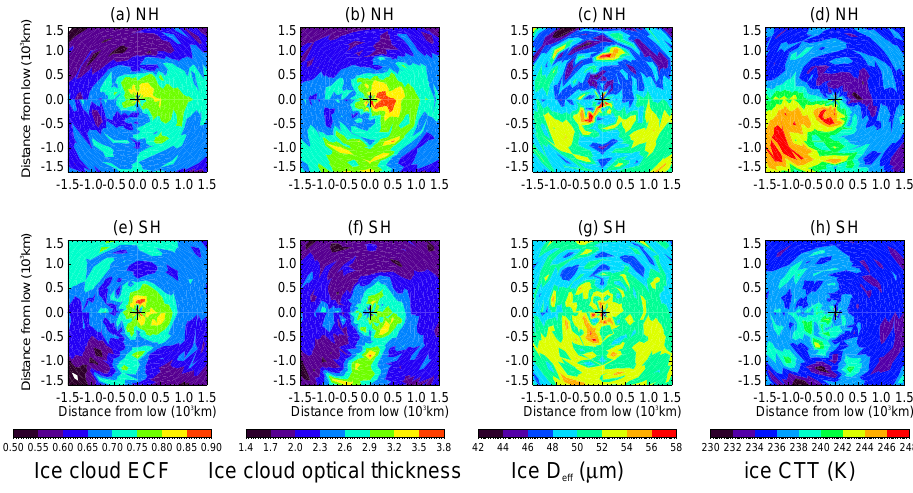
Fig. 17. Same as Fig. 16, except for ice cloud ECF, τ , D e , and T C , ICE